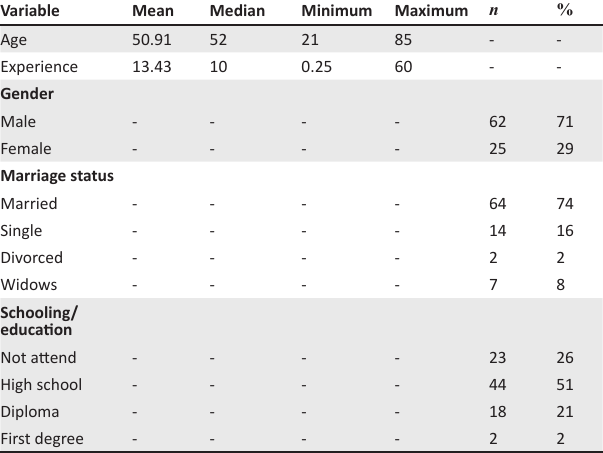
TABLE 1: Socio-economic characteristic of the respondents. Variable